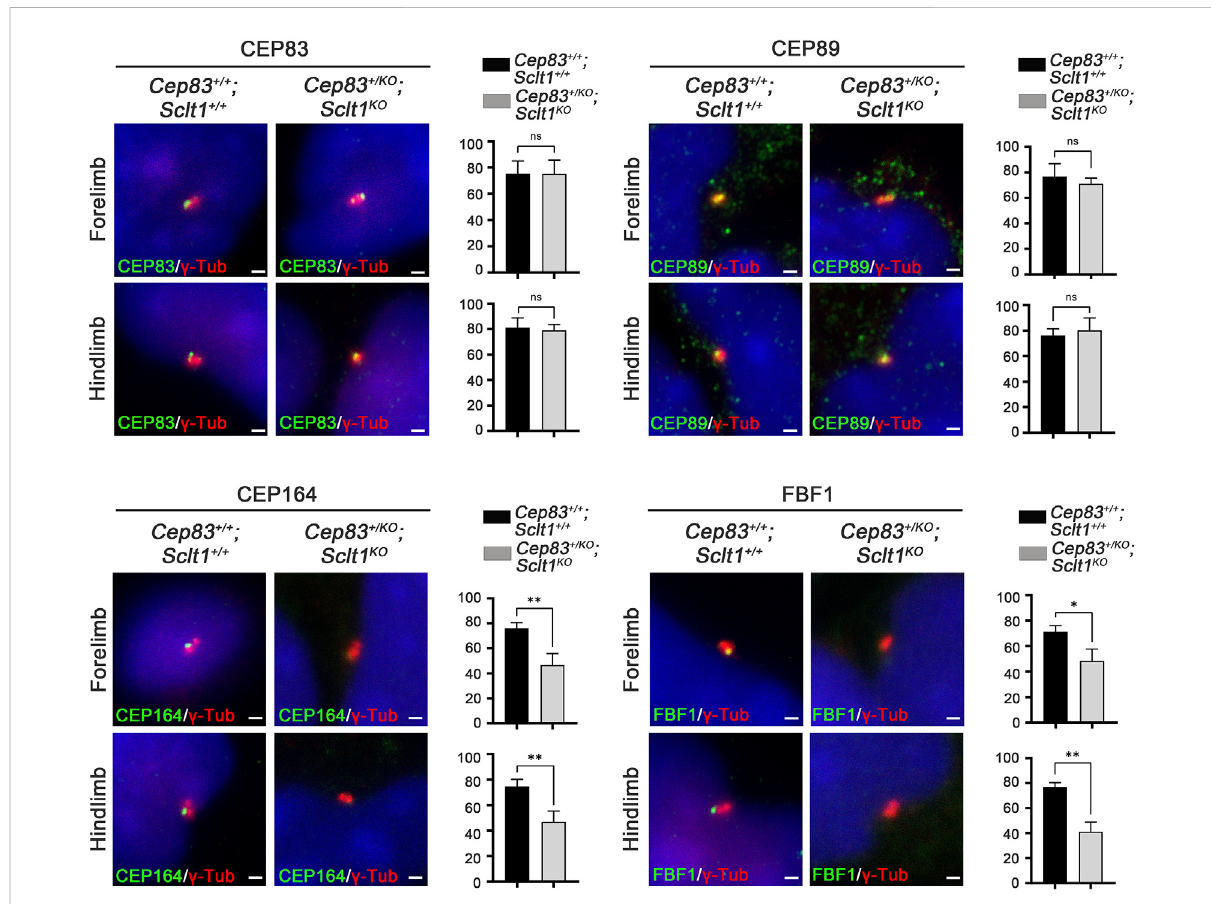
FIGURE 5 HeterozygosityofCep83in Sclt1 mutantdisrupts completeDAP formationintheforelimbSclt1mutantembryoshad furtherdisrupted forelimb digit patterning by heterozygous loss of Cep83. To con fi rm the role of Cep83 in complete DAP assembly in Sclt1 mutant mice, limb mesenchymal cells were analyzed with DAP proteins speci fi c antibodies to determine their proper localization in basal bodies. Scale bars = 1 µm. Quantitative analyses were done with more than 150 cells counted and statistical analysis with Student ′ s t tests were used (* p < 0.05; ** p <